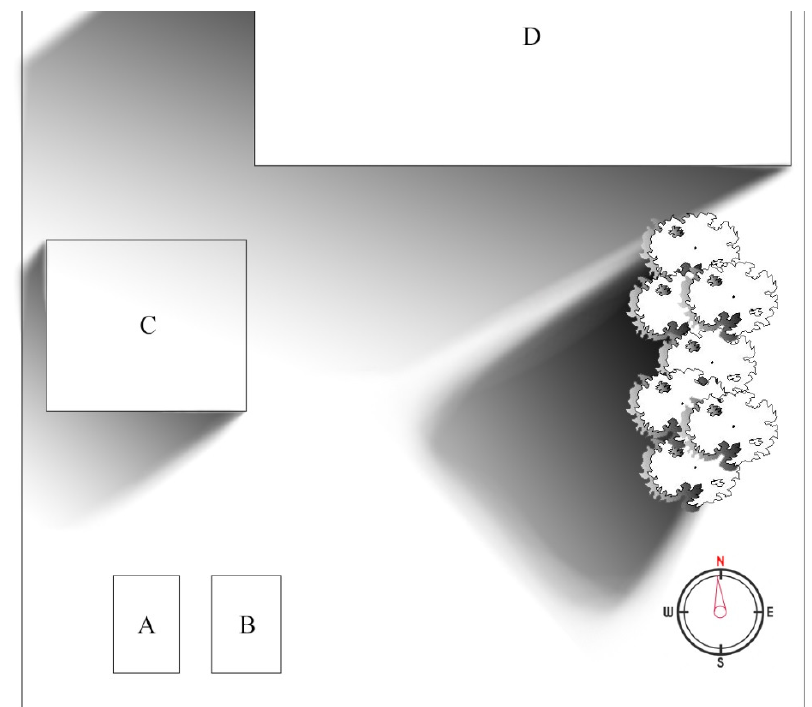
Figure 6. A rough sketch of the plot where solar panels ( A and B ) were placed. Rectangles named C and D represent a shed and a household in the vicinity. A tree line was also marked on the right side. Gradient areas are a rough representation of cast shadows around the early morning, when they were the biggest